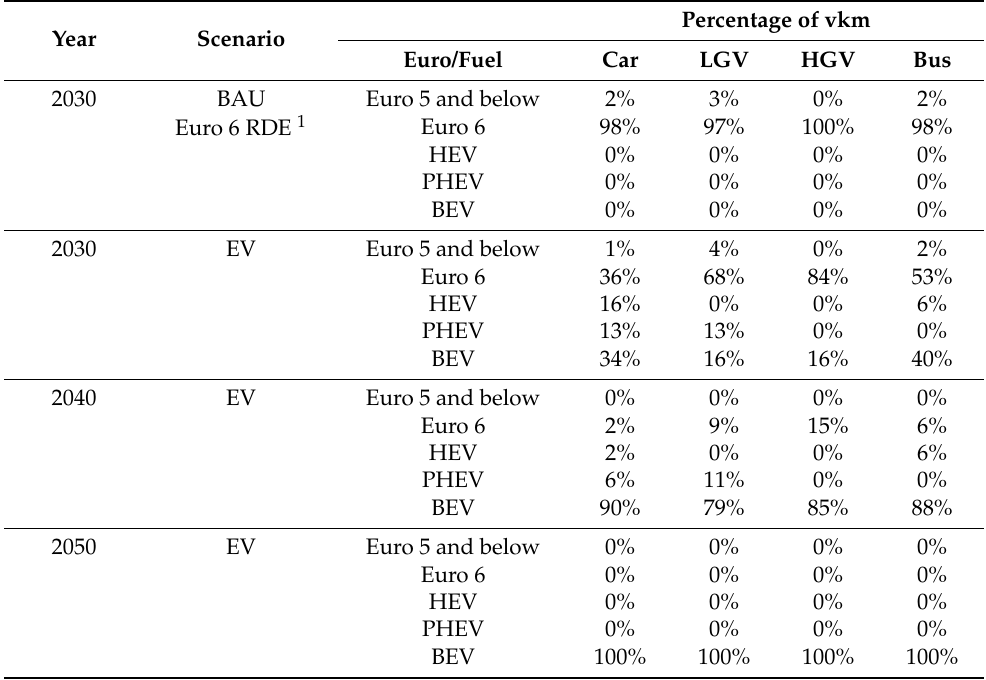
Table 1. Vehicle type fleet compositions for the year 2030; values represent the percentage of vkm broken down by the euro standard or fuel type for each vehicle type, for each